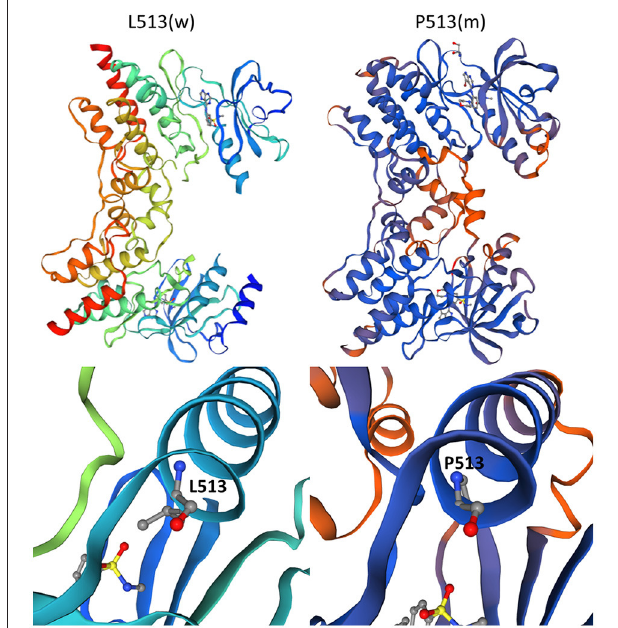
FIGURE 3 | The 3D models of TNNI3K . The left panel depicts wild-type and the right panel shows mutant TNNI3K